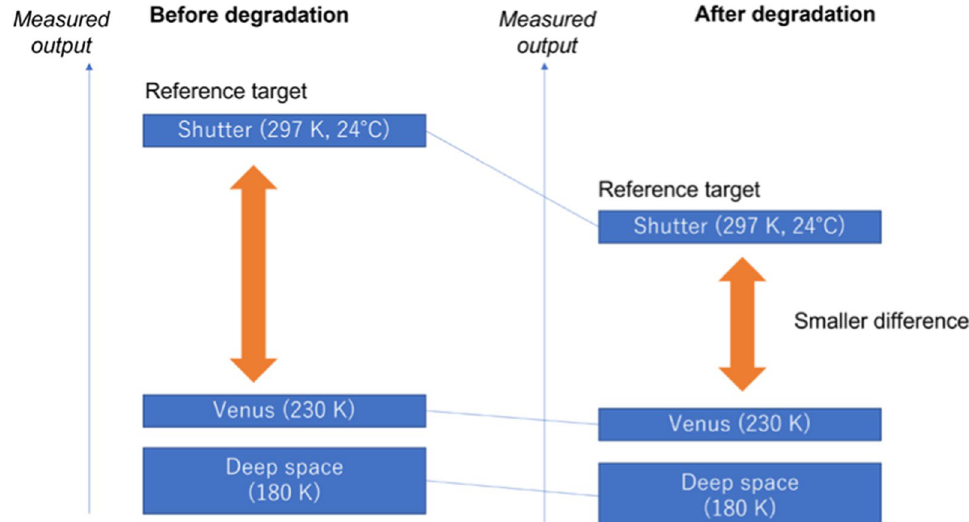
Fig. 2 Schematic view of a change of output brightness temperature of Venus relative to temperatures of the shutter and deep space due to sensitivity degradation of LIR. It is noted that the deep space temperature is not a real temperature but an apparent